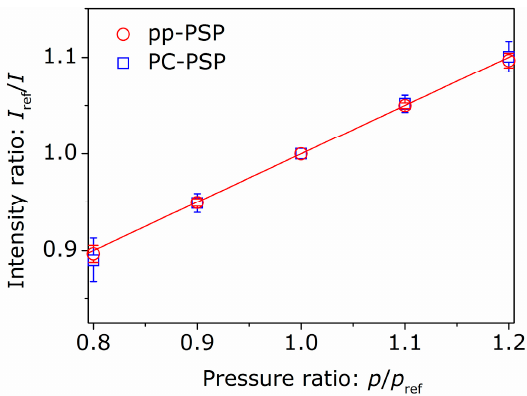
Figure 2. Stern-Volmer plots for polymer-particle pressure-sensitive paint (pp-PSP) and Stern-Volmer plots for polymer-particle pressure-sensitive paint (pp-PSP) and polymer-ceramic pressure-sensitive paint (PC-PSP), where (cid:1868) (cid:2928)(cid:2915)(cid:2916) = 100 kPa . polymer-ceramic pressure-sensitive paint (PC-PSP), where p ref “ 100 kPa.